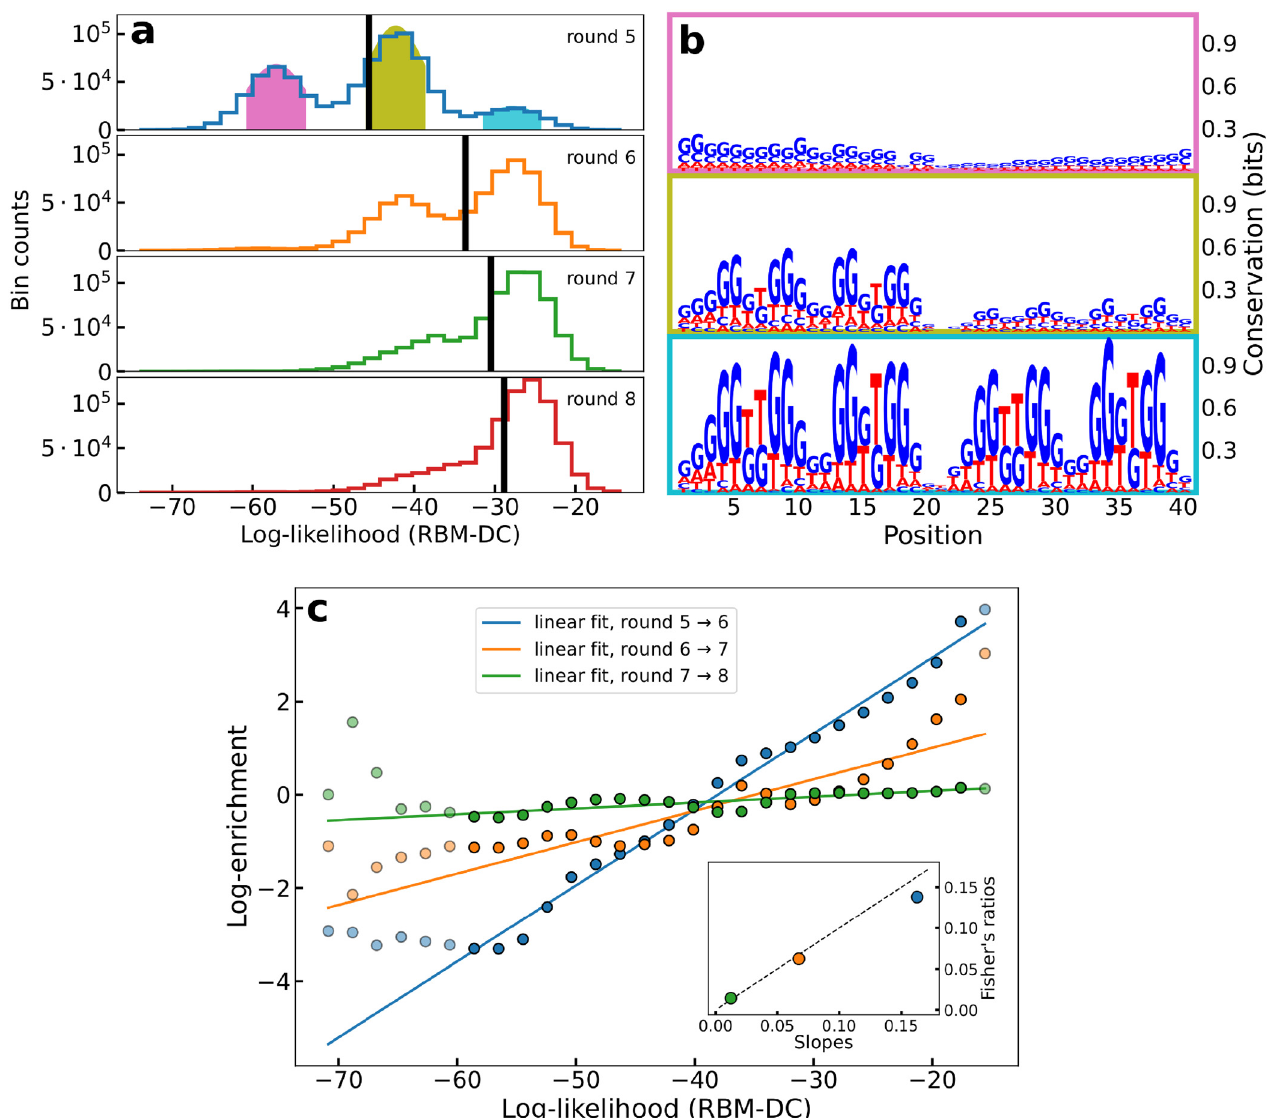
Fig 2. The RBM log-likelihood is strongly correlated to sequence fitness. a : Histograms of the log-likelihood of all sequences in the dataset at different rounds, obtained through RBM-DC trained on the sequences from round 6. The black line denotes the average log-likelihood. b : Logos of the sequences in each colored-shaded peak of the log-likelihood observed at round 5. c : Enrichment log-ratios log E vs. log-likelihoods log p averages over the sequences in each bin of the histograms of panel A. The three sets of points corresponds to rounds r = 6, 7, 8. Linear fit are estimated from points with log-likelihood in the interval ( − 60, − 17) (not shaded in the plot) only, to exclude under-sampled bins cumulatively representing 0.5%, 0.3%, and 0.3% of the sequences, respectively at rounds 6, 7 and 8. Inset: scatter plot of the slopes of the linear fits (x-axis) and of the log-likelihood Fisher ratios (y-axis); linear dashed line: y = x .